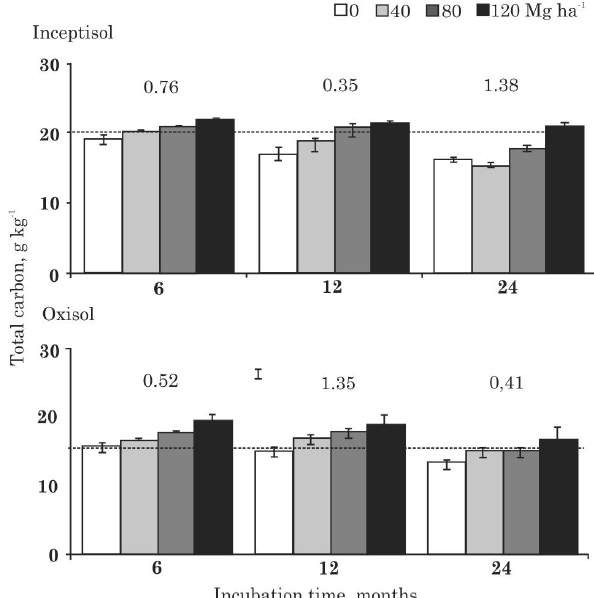
Figure 2. Carbon content in Inceptisol and Oxisol samples with time for different doses of filter cake application. Error bars represent the standard error of the mean. Horizontal dashed line represents values for untreated soil at the beginning of the experiment. Numbers refer to least significant difference (Tukey test, p <